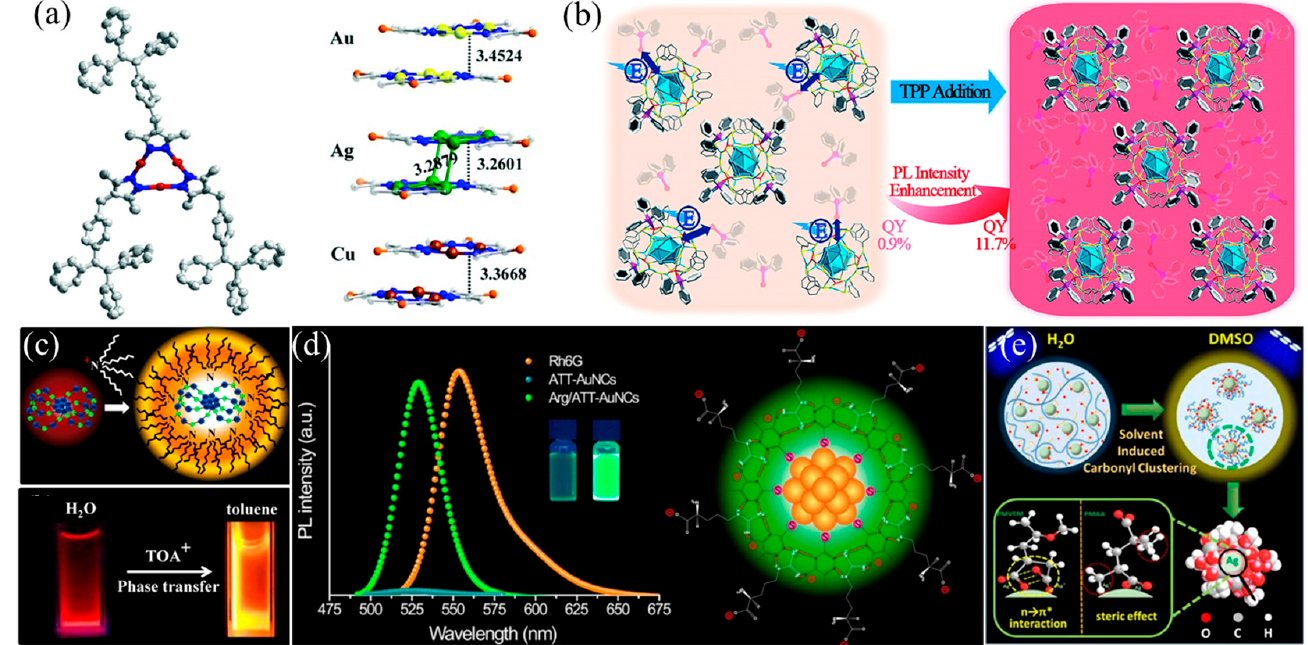
Figure 5. ( a ) Schematic representing the crystal structure of M 3 and interlayer stacking structures of Au 3 , Ag 3, and Cu 3 . Reprinted/adapted with permission from Ref. [43]. 2019, copyright Royal Society of Chemistry. ( b ) Mechanism model of TPP dissociation-aggregation process. Reprinted/adapted with permission from Ref. [46]. 2018, copyright Royal Society of Chemistry. ( c ) Mechanism model of binding TOA to Au 22 (SG) 18 and a digital photograph of Au 22 (SG) 18 and TOA-Au 22 . Re- printed/adapted with permission from Ref. [10]. 2015, copyright American Chemical Society. ( d ) Mechanism model of the Arg-mediated ATT-AuNCs. Reprinted/adapted with permission from Ref. [47]. 2017, copyright American Chemical Society. ( e ) Mechanism model of the solvent-induced stage of Ag NCs. Reprinted/adapted with permission from Ref. [48]. 2017, copyright American Chemical Society.